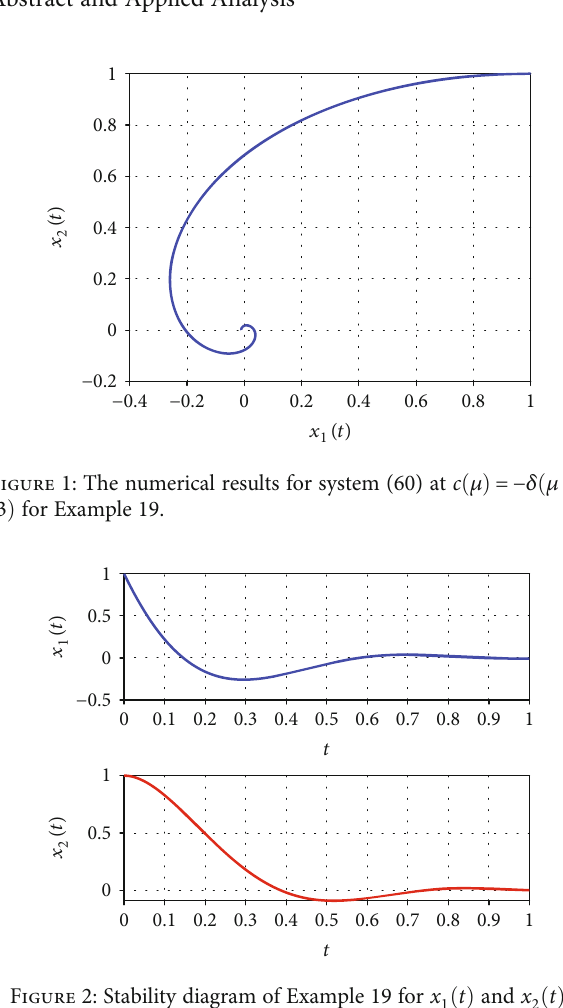
1 ð t Þ and x 2 ð t Þ .